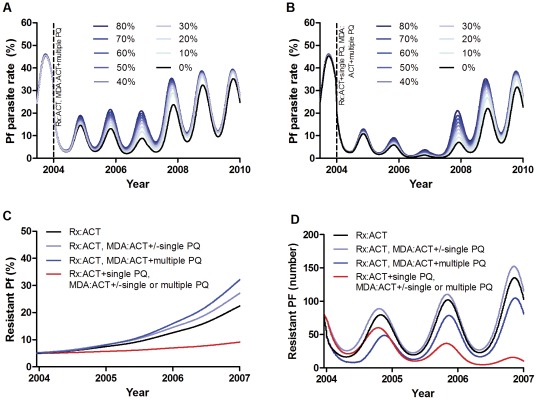
Artemisinin resistance and different elimination strategies.Effect of an increasing prevalence of resistance (defined as the proportion of infections which are artemisinin resistant) from 0% to 80% on the success of MDA with ACT plus multiple rounds of primaquine and treatment with A ACT or B ACT plus single dose primaquine from 2004–2007. C–D effects of different treatment and MDA regimes on the spread of artemisinin resistance (C: prevalence of resistant infections, D: number of resistant infections), presuming a starting prevalence of resistance of 5%. Interventions ceased in 2007.